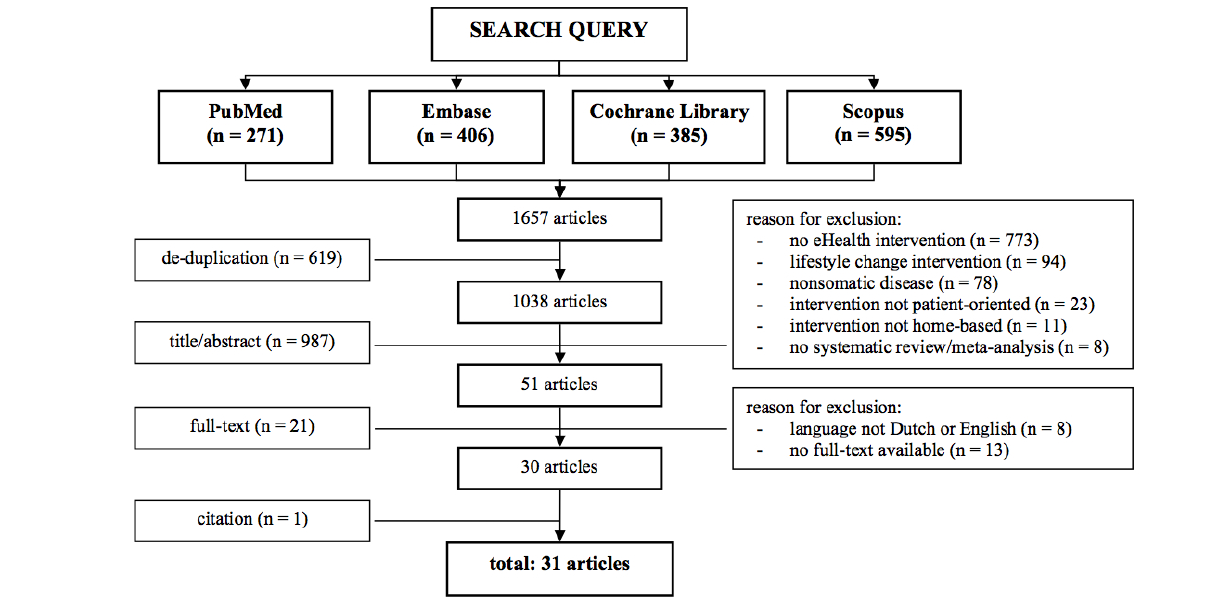
Figure 1. Flow diagram of the literature search on the effectiveness of eHealth